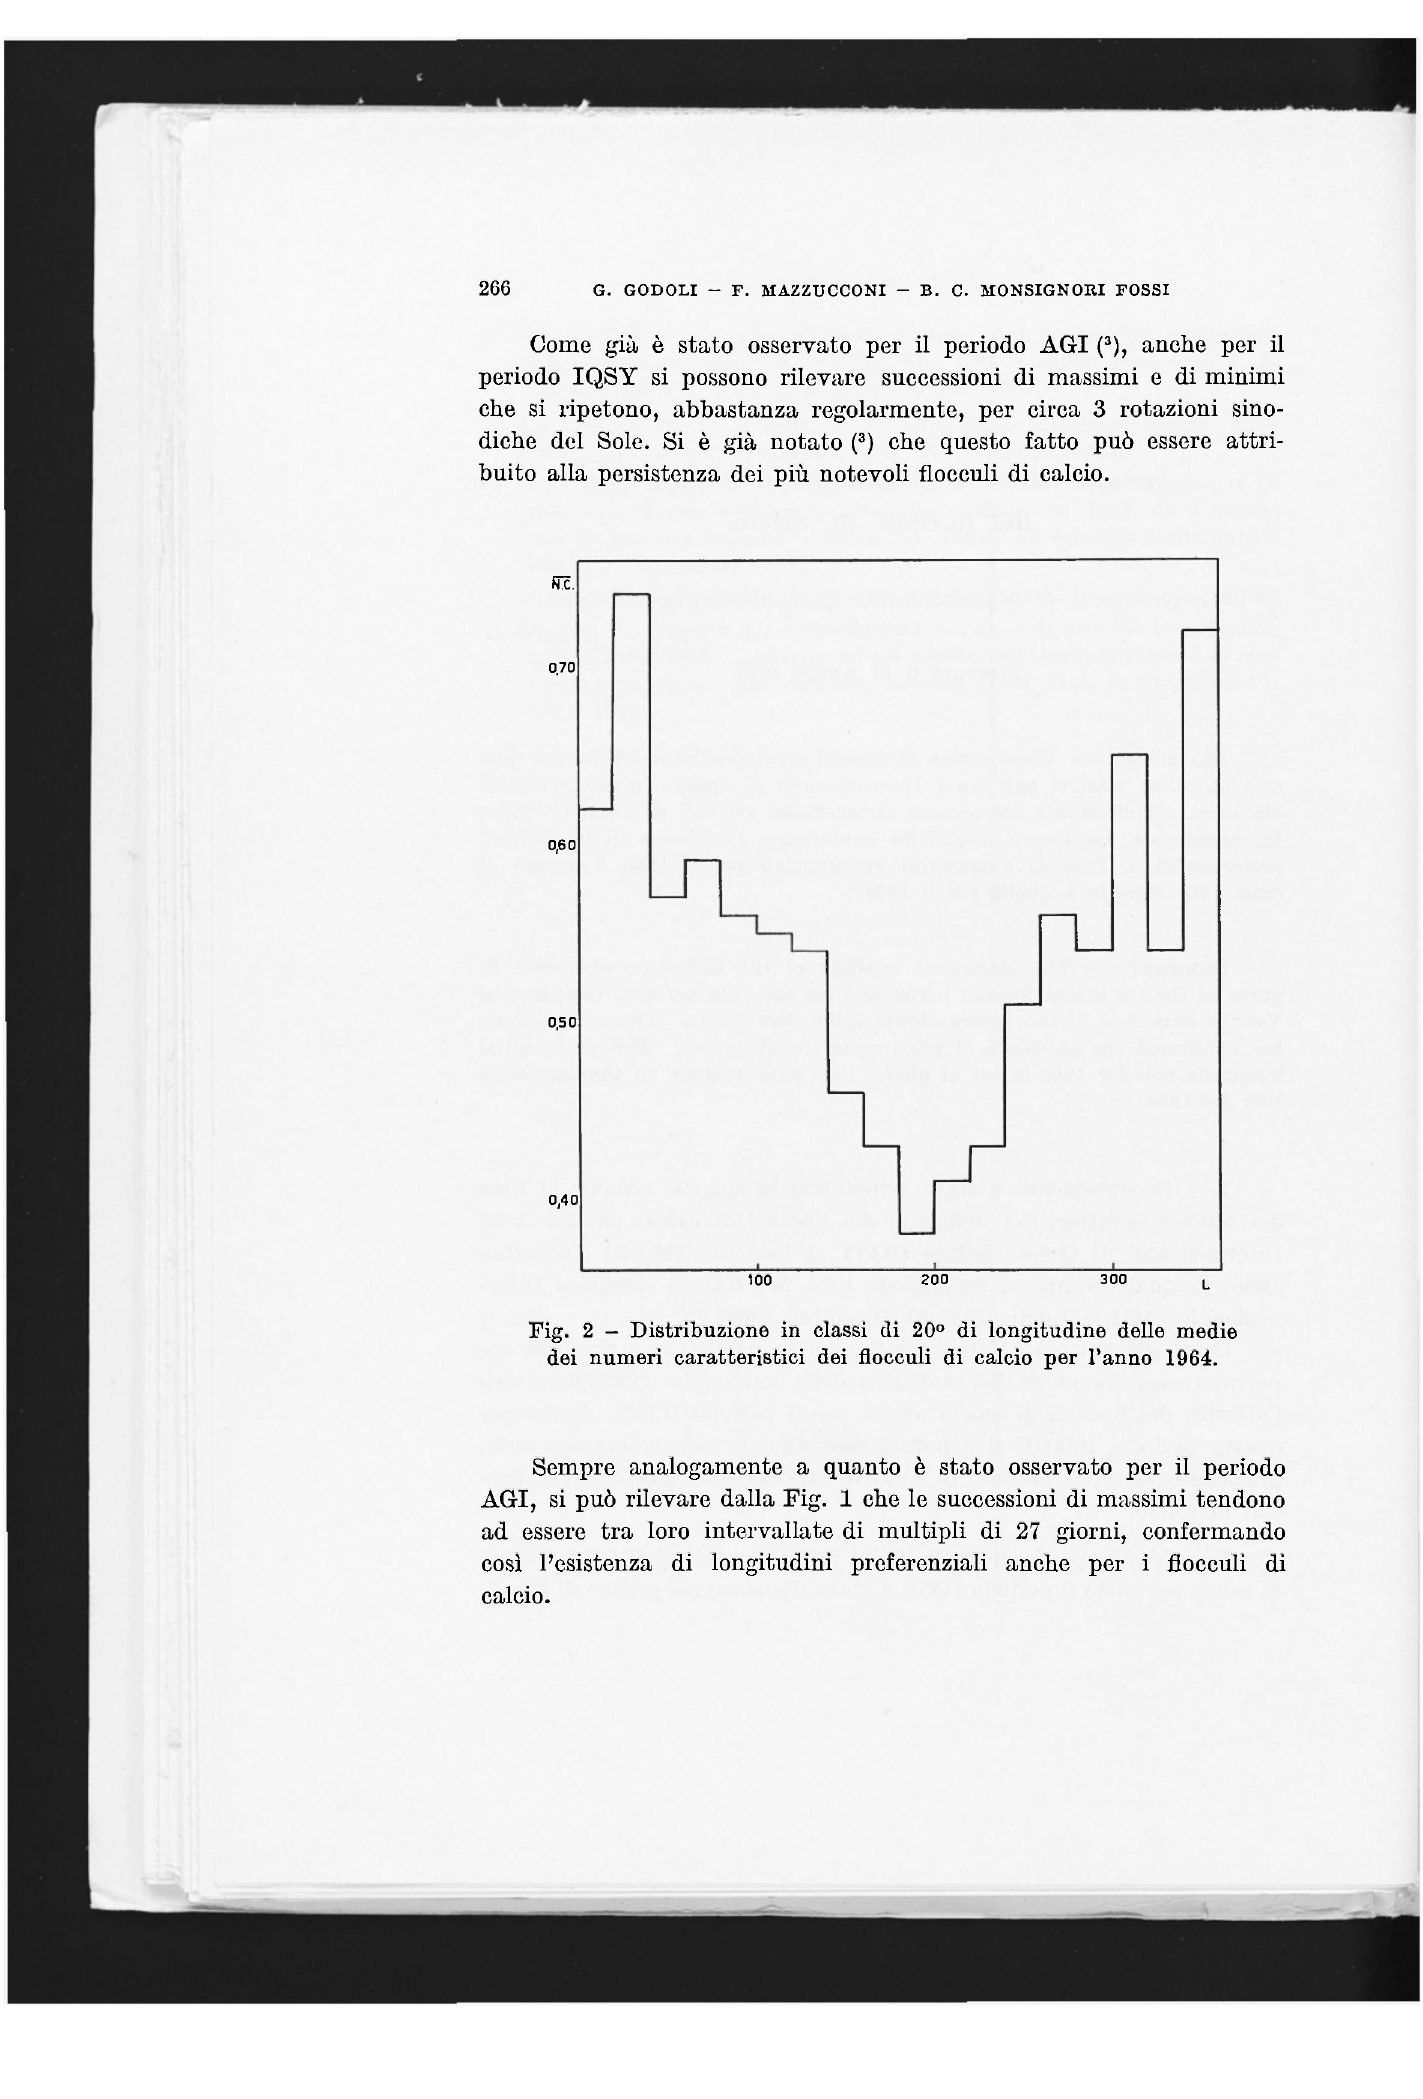
G. GODOLI - F. MAZZUCCONI - B. C. MONSIGNORI FOSSI Come già è stato osservato per il periodo AGI ( 3 ), anche per il periodo IQSY si possono rilevare successioni di massimi e di minimi che si ripetono, abbastanza regolarmente, per circa 3 rotazioni sino- diche del Sole. Si è già notato ( 3 ) che questo fatto può essere attri- buito alla persistenza dei più notevoli floccnli di calcio.